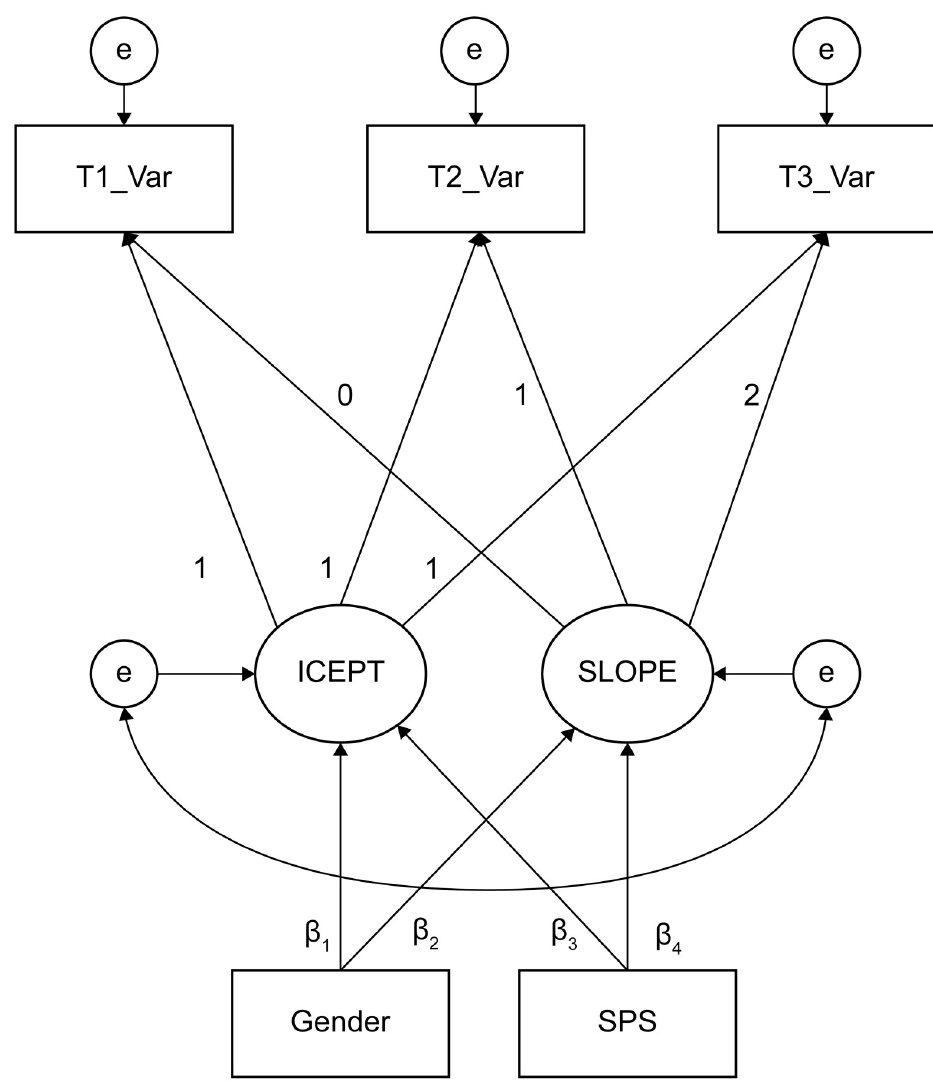
Fig 2. Hypothesized latent growth curve model with gender and SPS as predictor variables. T1, T2, and T3 represent pre-, post-, and three-months follow-up measurements, respectively. “Var” indicates study variables measured with the Bidimensional Resilience Scale (BRS), Rosenberg Self Esteem Scale (RSES), General Self Efficacy Scale (GSES), and the Birleson Depression Self Rating Scale for Children (DSRS). SPS was measured with the Japanese version of the Highly Sensitive Child Scale for Adolescence